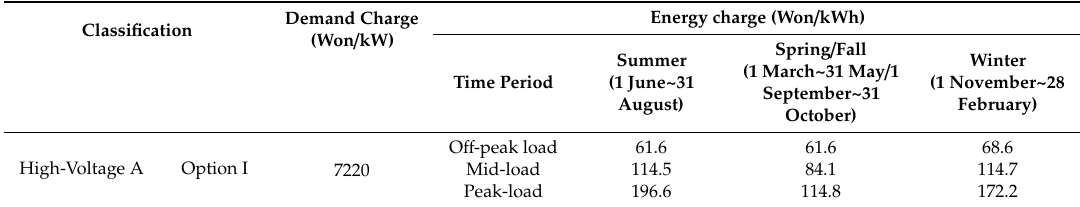
Table 7. An example of electric rates table for an industrial